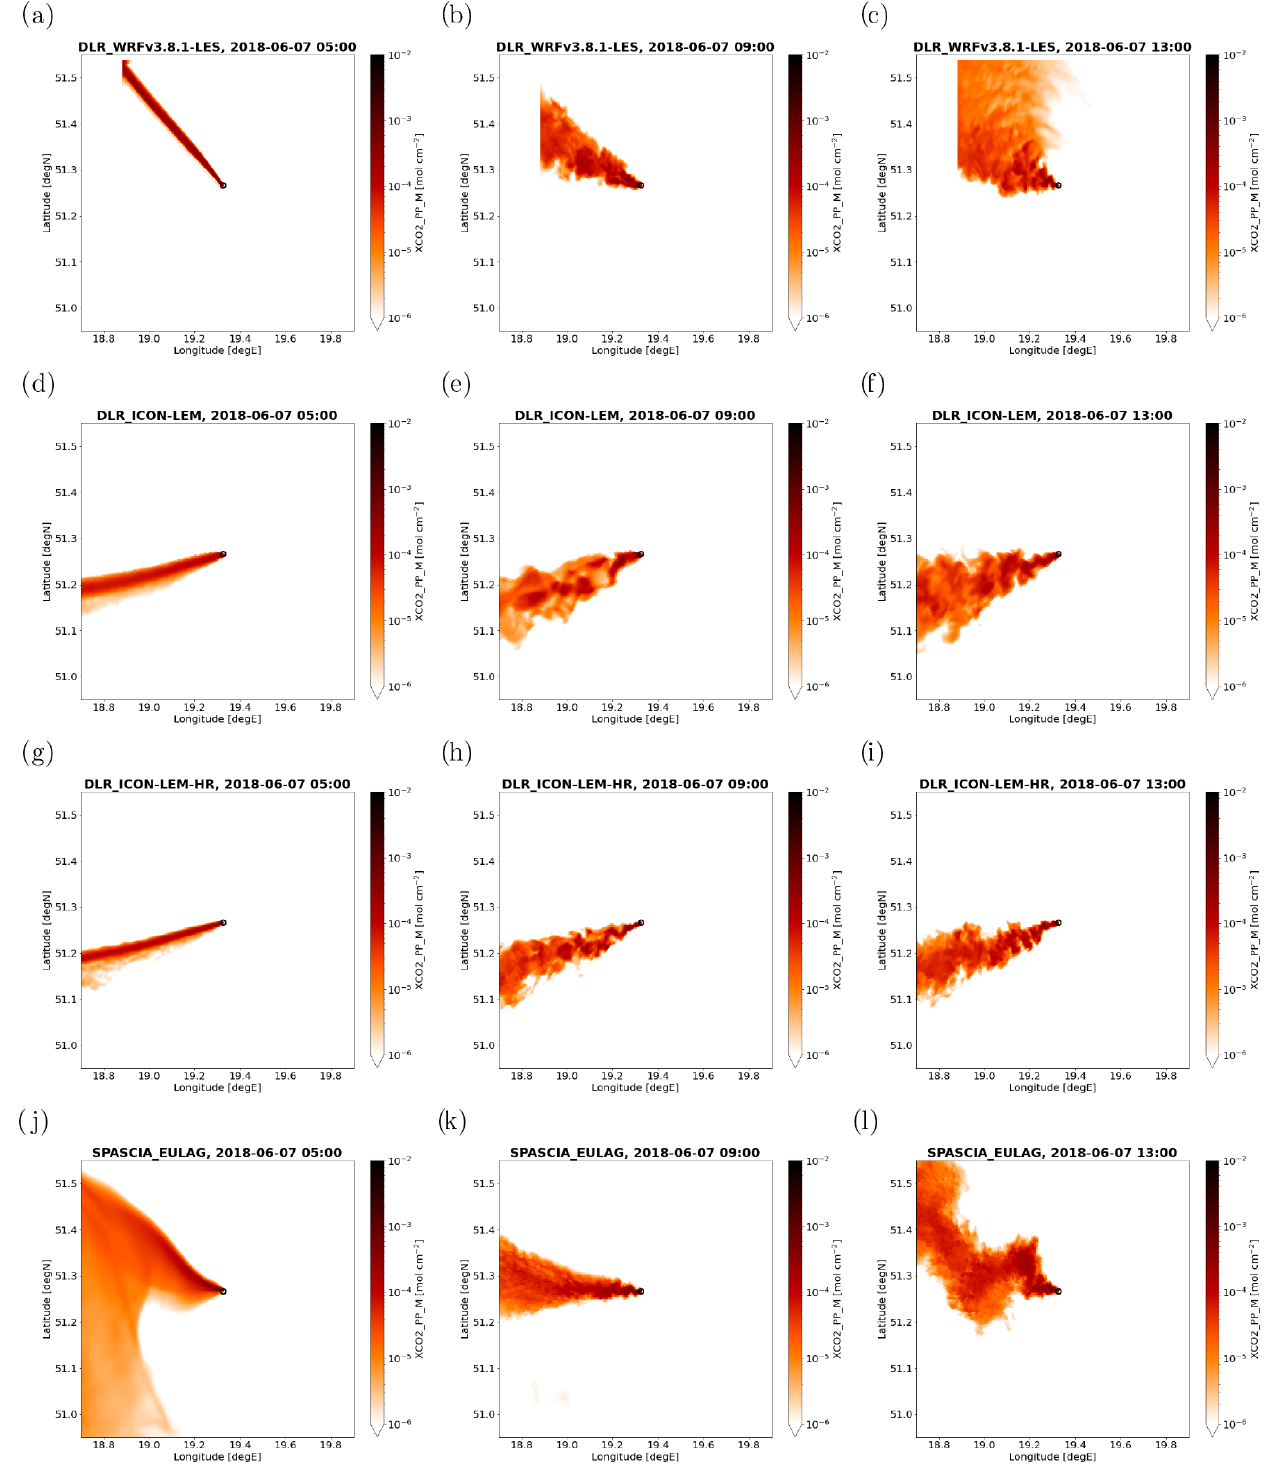
Figure 3. Time evolution of the Bełchatów total column XCO 2 plume on 7 June 2018 from 05:00 to 13:00UTC in the LES models of WRF-LES (a–c) , ICON-LEM (d–i) , and EULAG (j–l)